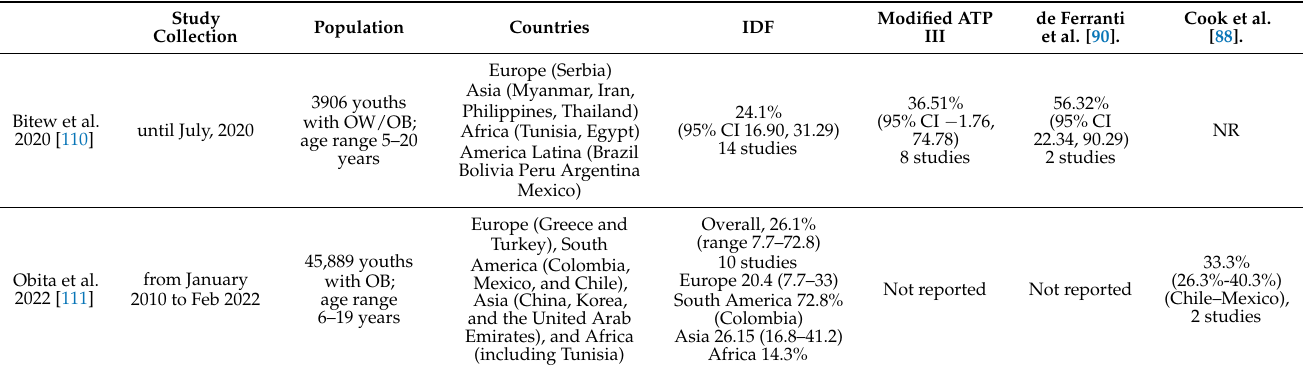
Table 2. Pooled prevalence of MetS according to different definitions from the two most recent systematic